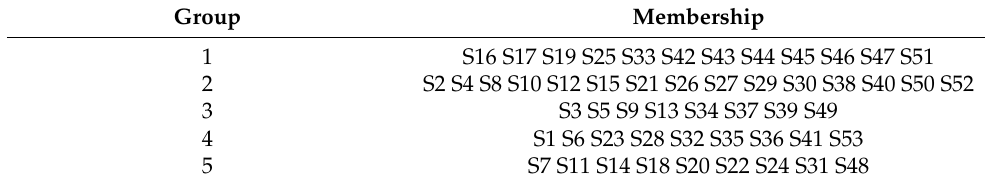
Figure 6. The study group based on the results of community detection. Table 3. Dataset: Summary Statistics.